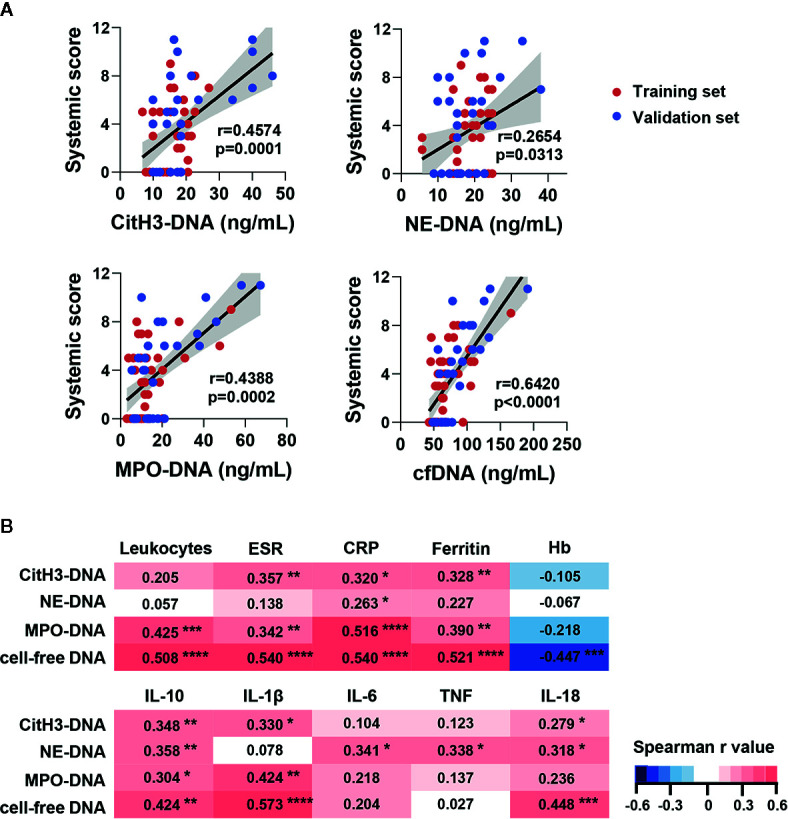
Circulating NETs signature in AOSD patients was correlated with systemic inflammation. (A) Circulating NETs signature was correlated with systemic score in training and validation set. (B) Correlation matrix of NETs signature with laboratory tests and serum cytokine level in AOSD. Heatmap manifests the strength of relationship by Spearman’s correlation analysis. AOSD, adult-onset Still’s disease; HC, healthy control; ESR, erythrocyte sedimentation rate; CRP, C-reactive protein; Hb, hemoglobin; IL, interleukin; TNF, tumor necrosis factor. *p < 0.05, **p < 0.01, ***p < 0.001, ****p < 0.0001.